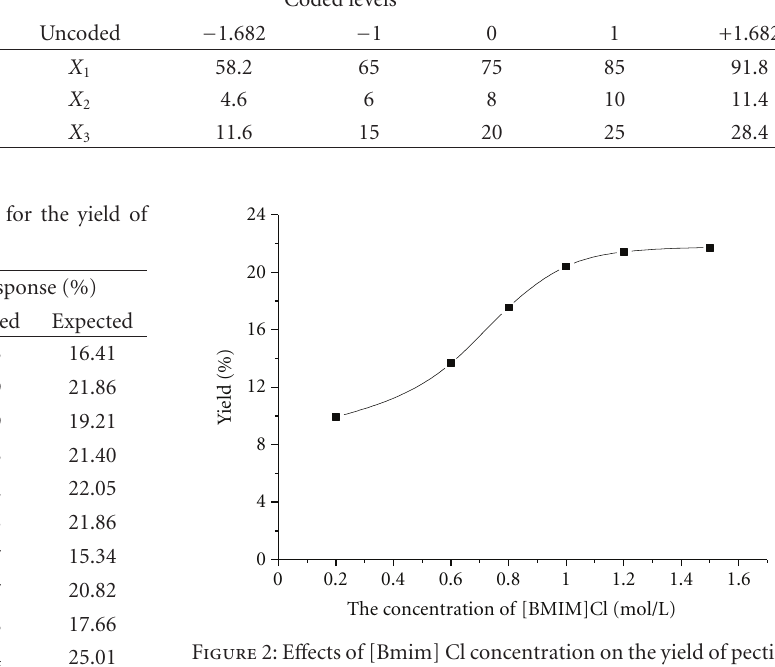
As shown in Figure 2, the yield of pectin increased gradually as the increase of the [Bmim] Cl